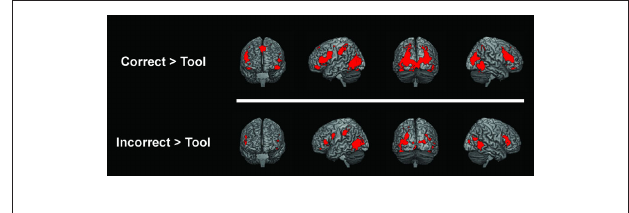
FIGuRE 2 | fMRI activations for [correct > tool] (upper panel) and [incorrect > tool] (lower panel) are shown in red. All activations shown were statistically significant at an FDR corrected P <